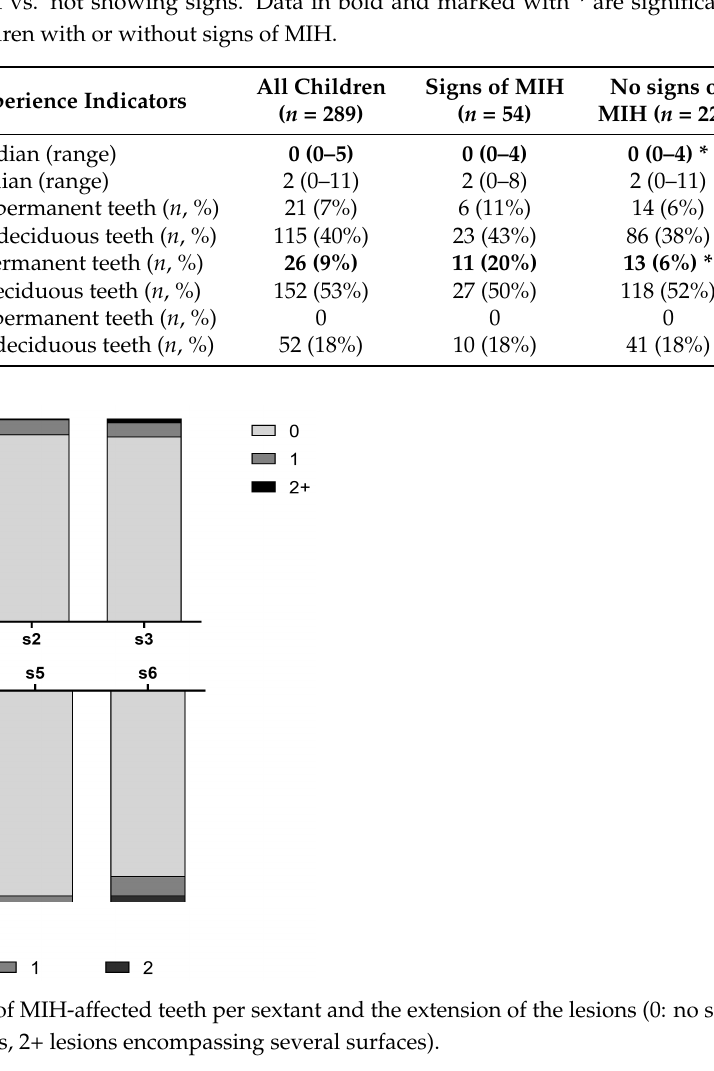
Table 1. Outcomes related to dental caries experience in the whole sample and specific for children showing signs of MIH vs. not showing signs. Data in bold and marked with * are significantly dif- ferent between children with or without signs of MIH.